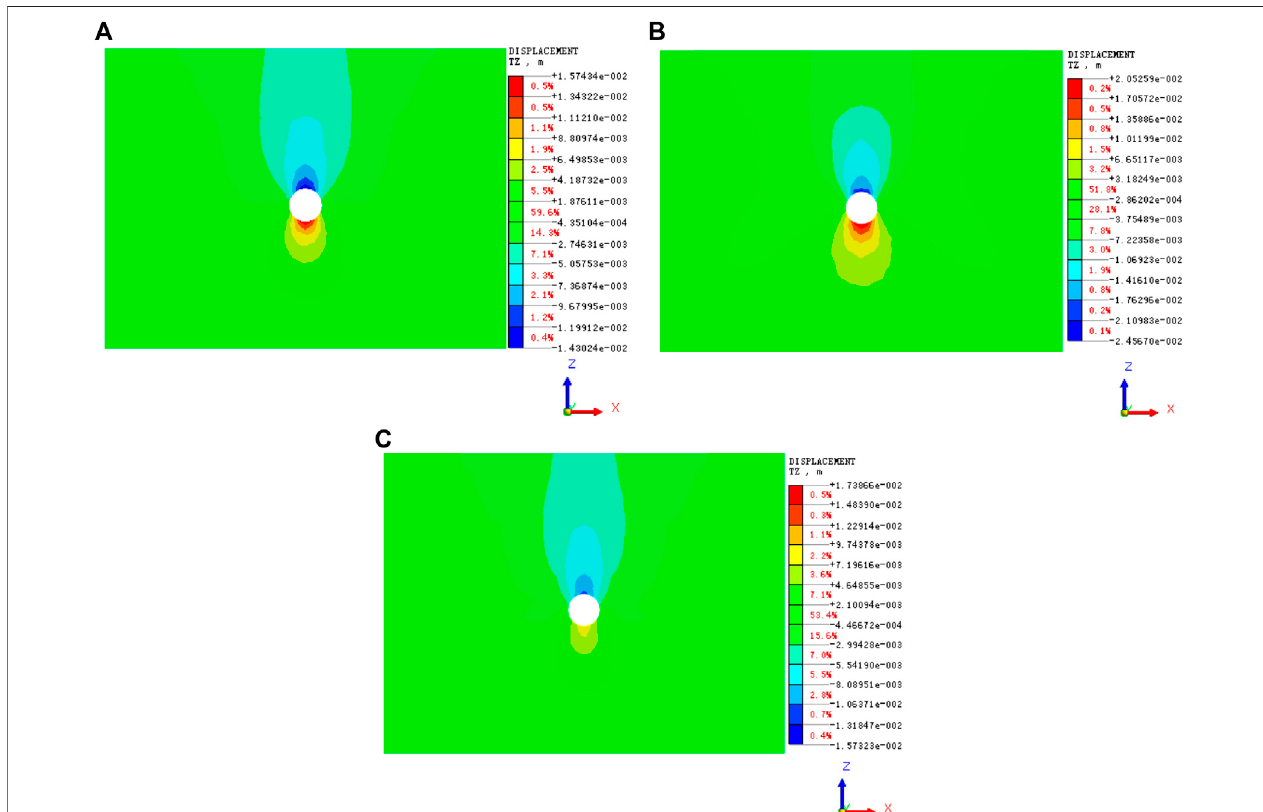
FIGURE 12 | Cloud map of section I-I under different conditions. (A) Cloud map of surrounding rock under Condition 1. (B) Cloud map of surrounding rock under Condition 2. (C) Cloud map of surrounding rock under Condition 3.